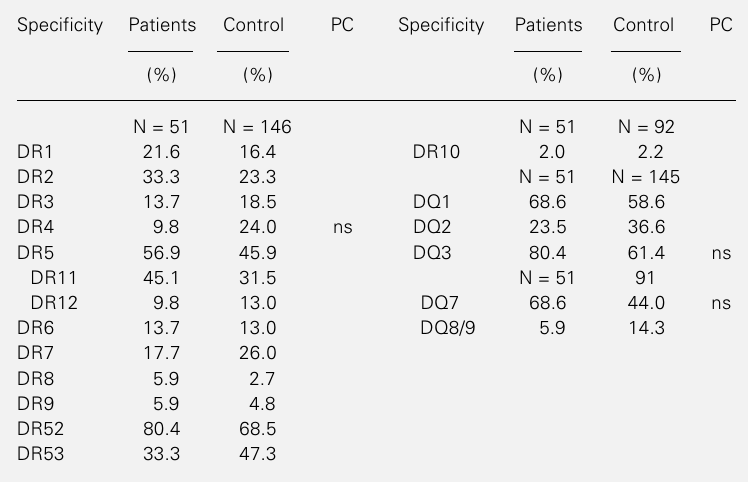
Table 2 - HLA-DR and DQ antigen frequencies in patients with the LL form of leprosy and in the control group. ns = Nonsignificant (indicated only if P<0.05 before correction); P = probability; PC = corrected probability (Chi-square test). Specificity Patients